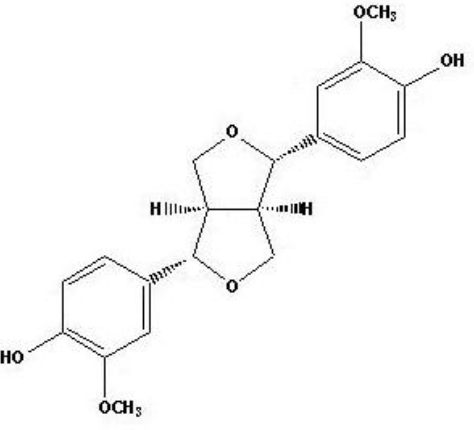
Figure 1. Chemical structure of ( + )-pinoresinol derived from Sambucus williamsii